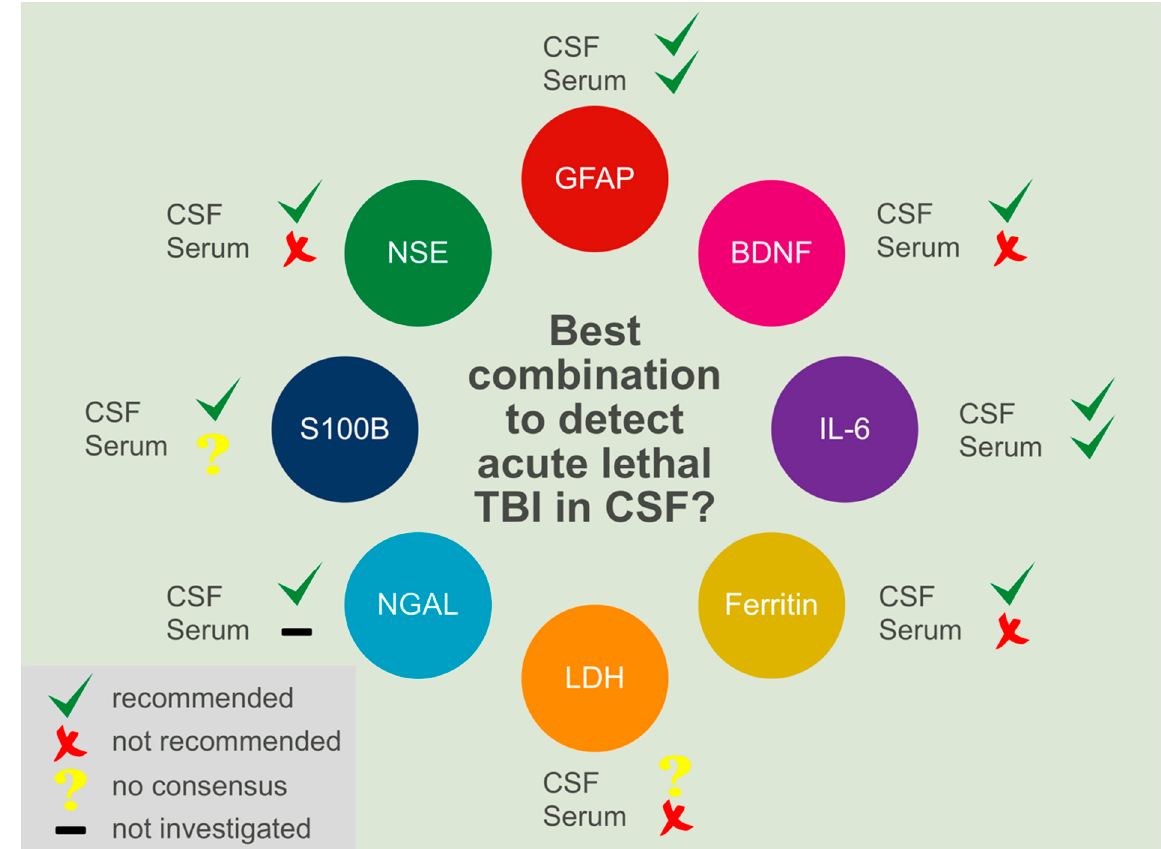
Figure 1. A graphical summary of previous post mortem studies by the authors [6–9] and other post mortem studies [4,5,12,13,20,21] for the biomarkers in this study, including a summary of whether these were considered to be useful for the detection of acute lethal TBIs. Most studies recommended the use of cerebrospinal fluid markers to investigate the respective TBI-related biomarkers compared to combined control groups. The use of serum markers was only recommended in a minority of studies.